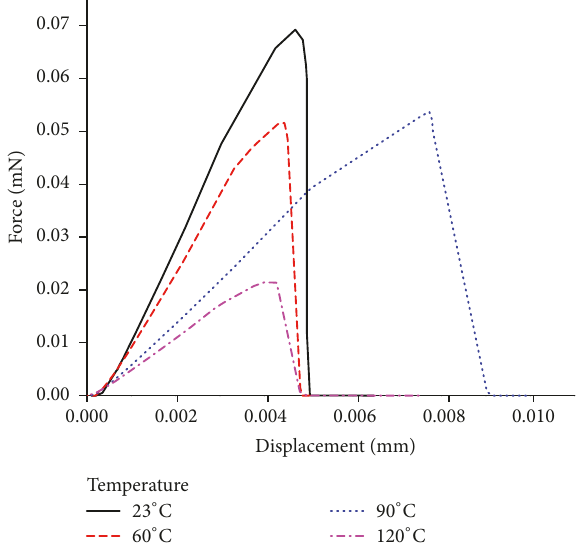
Figure 10: Simulated force-displacement curves under different temperature.